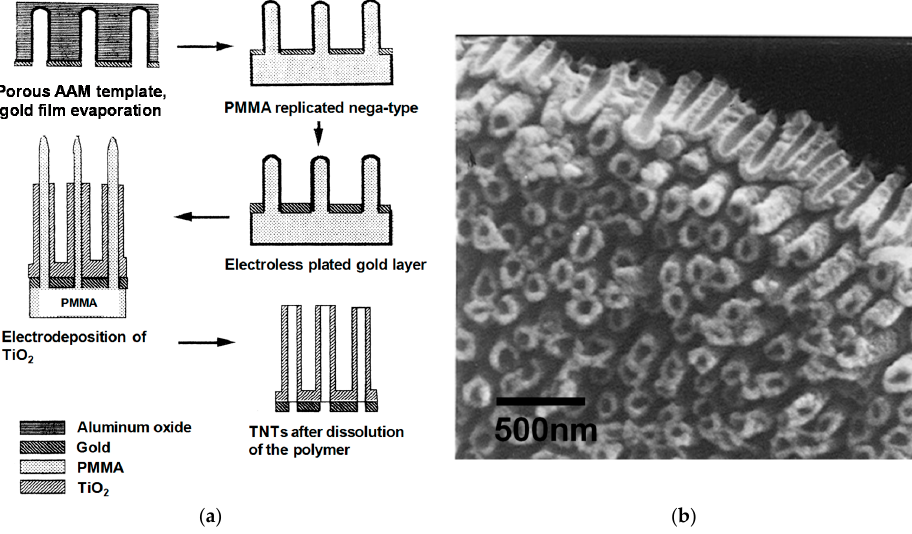
Figure 7. ( a ) Schematic diagram of the template-assisted synthetic process via replication and electrodeposition; and ( b ) SEM image of top and cross-section views for TiO 2 NTs obtained after 20 min-electrodeposition. Reprinted with permission from [34]. Copyright 1996 American Chemical Society.